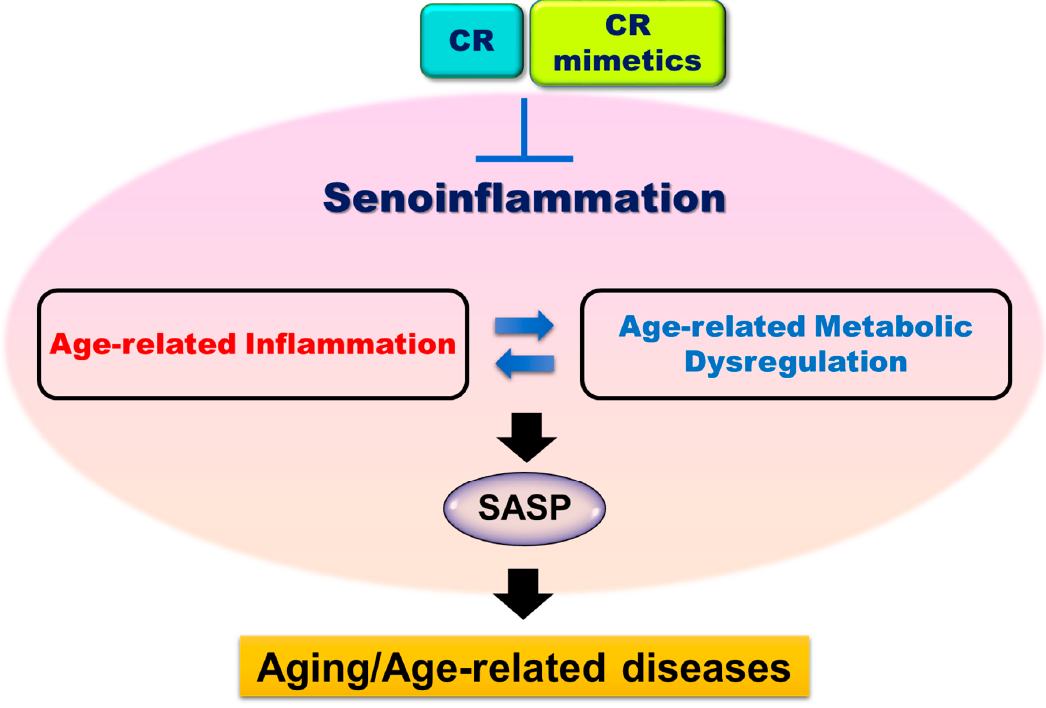
Figure 1. Possible mechanism of senoinflammation in aging. During aging, the continuous age-related inflammatory responses that cause metabolic dysregulation to form a vicious cycle. Age-related inflammation and metabolic dysregulation result in the induction and activation of many pro-inflammatory genes, metabolic and signaling pathways, and SASP. This vicious cycle of age-related chronic inflammation and metabolic dysregulation underlies the senoinflammation phenomenon, which occurs because of the interaction between senescent cells, immune cells, adipocytes, hepatocytes, and myocytes. SASP, senescence associated secretory phenotype; CR, calorie restriction.